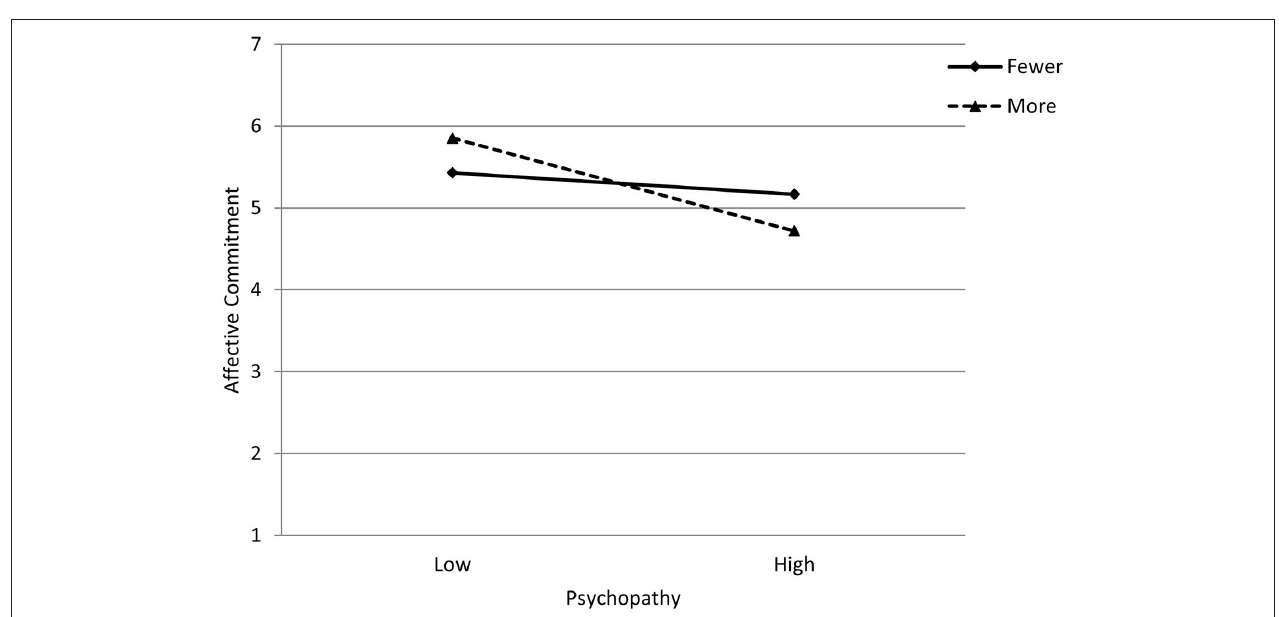
FIGURE 2 | Interaction between psychopathy and years of part-time and casual employment in their impact on affective commitment. Lines represent years of part-time and casual work at − 1SD = Fewer and + 1SD = More from the mean.